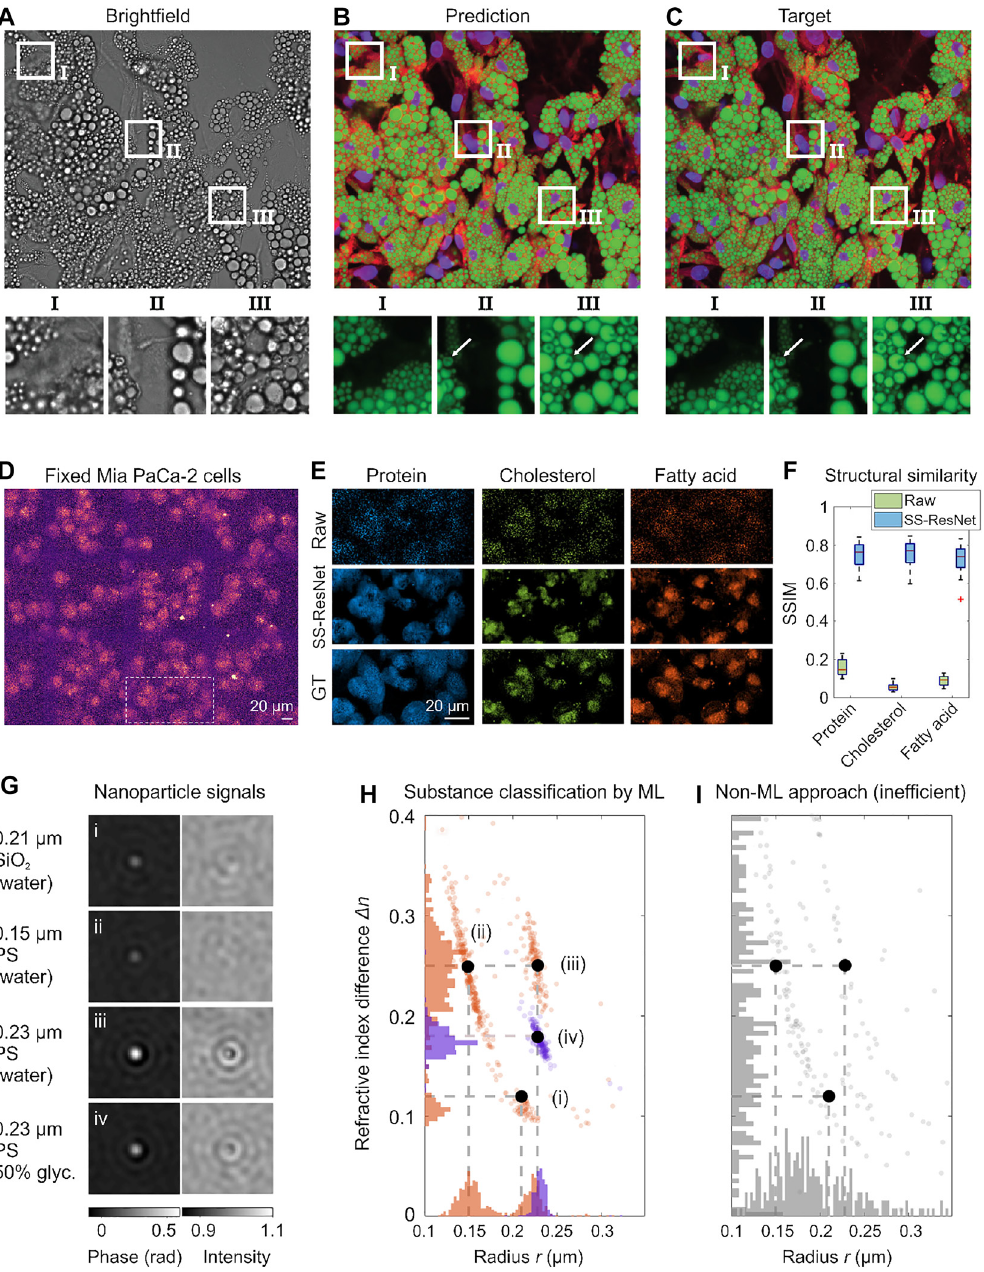
Figure 7: Quantitative imaging with deep